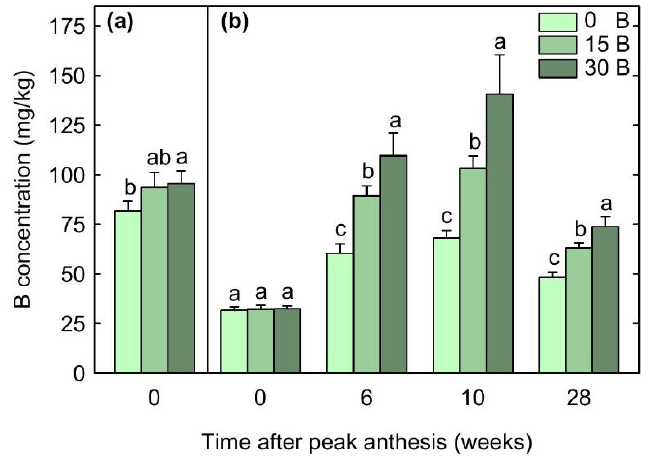
Figure 2. ( a ) Floral and ( b ) foliar boron concentrations of Hass avocado trees treated with 0, 15 or 30 g boron (B) per tree prior to anthesis. Means (+SE) with different letters within a time point are significantly different (generalised linear models, p < 0.05, n = 10 trees).